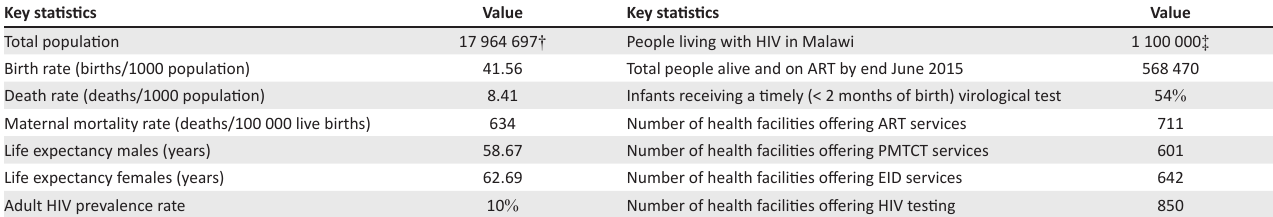
TABLE 1: Malawi key statistics: Brief demographic summary.